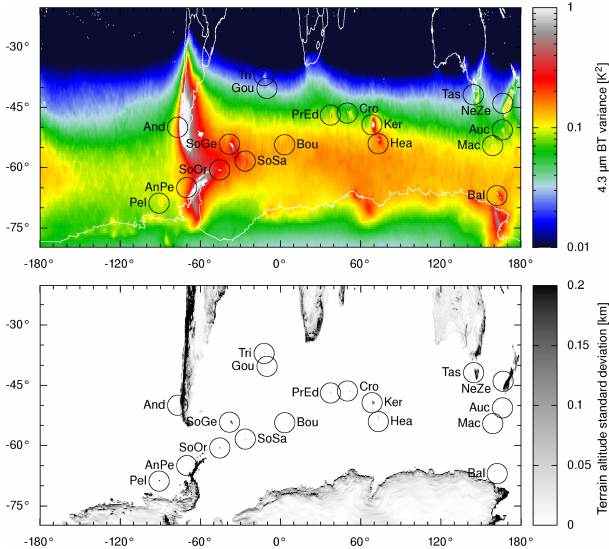
Figure 1. Top: multi-annual seasonal mean (April–October in 2003–2014) of detrended and noise-corrected AIRS 4.3µm bright- ness temperature variances due to stratospheric gravity wave activ- ity. Bottom: Terrain altitude standard deviations from 2min gridded global relief data (ETOPO2v2) at 0 . 25 ◦ × 0 . 25 ◦ horizontal resolu- tion. Black circles indicate the locations of orographic hotspots that are investigated in this study (see Table 1 for